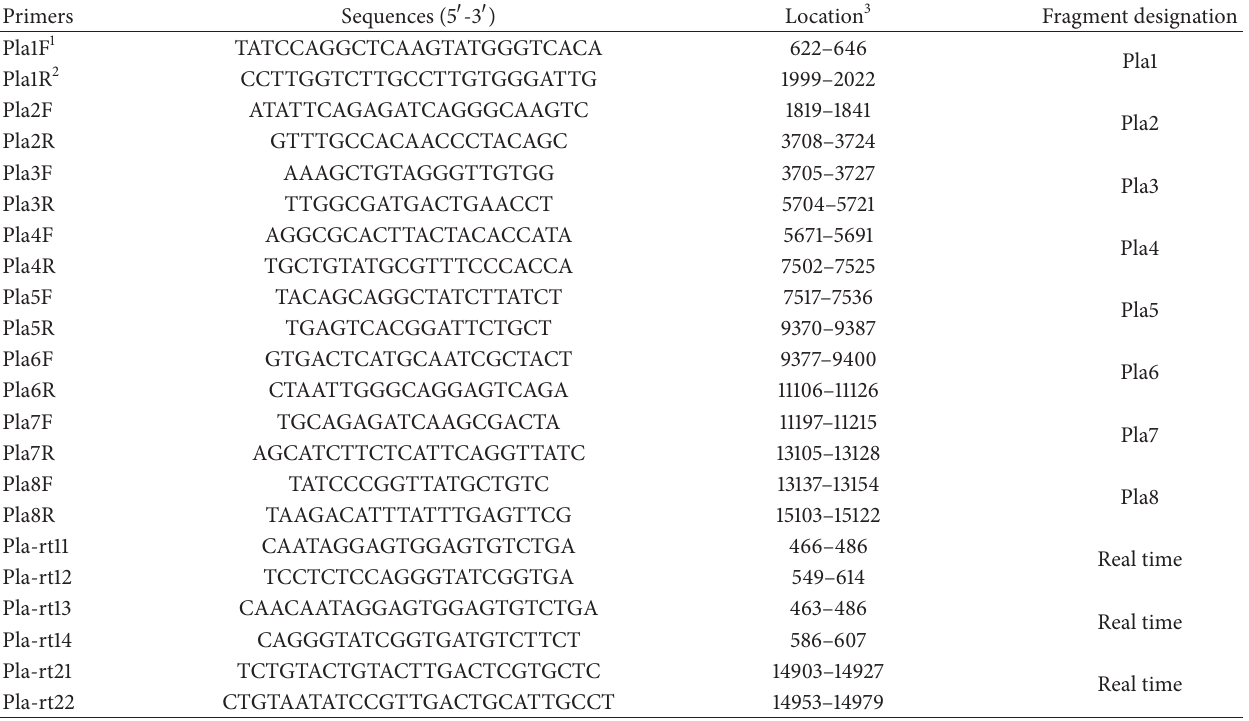
Table 1: Primers used in this